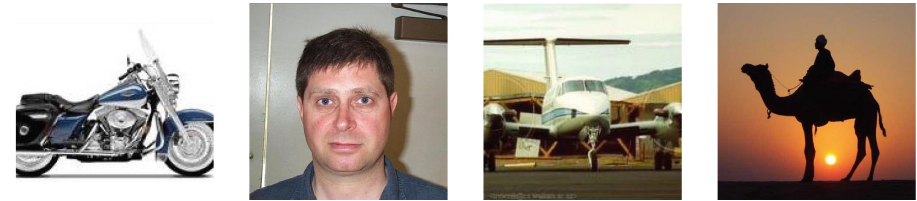
Figure 4. Sample from the Caltech dataset. From left to right: Bikes, Faces, Planes, Camels.